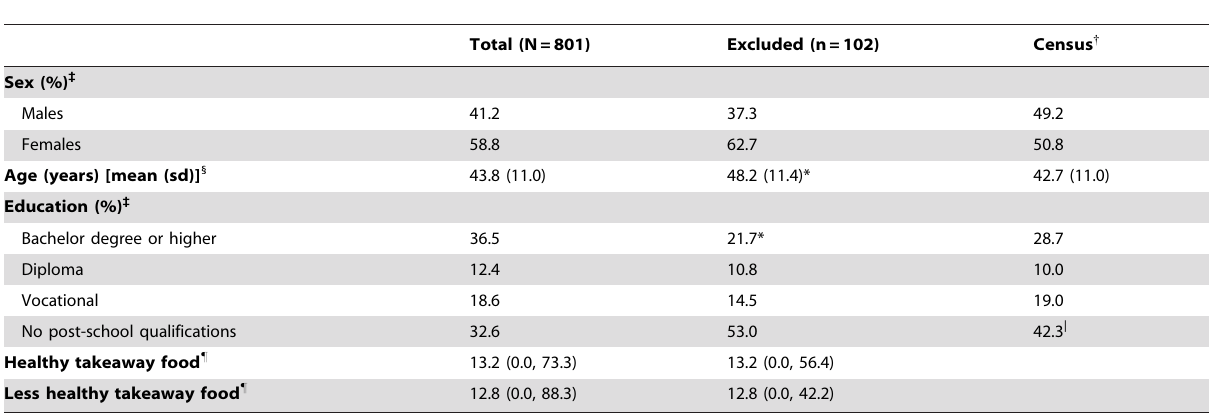
Table 2. Characteristics of participants and their takeaway food consumption scores.